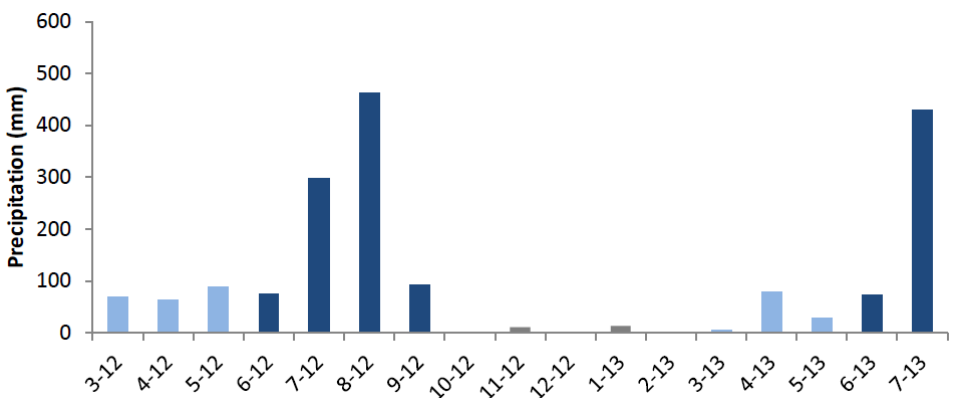
Figure 2. Rainfall patterns between March 2012 and July 2013 with the azmera (spring) rain season in light blue, the kiremt (summer) rain season in dark blue, and rainfall during the dry season in gray. The period plotted corresponds with the period between cambial marking and sampling of the stem disks.